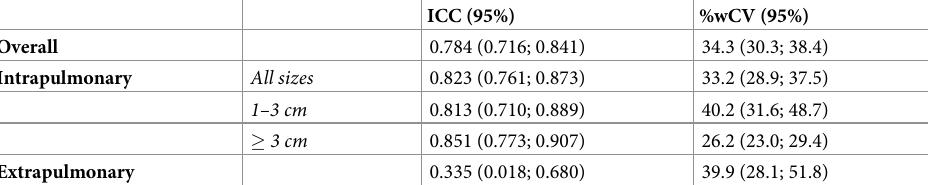
Table 3. Interrater reliability.